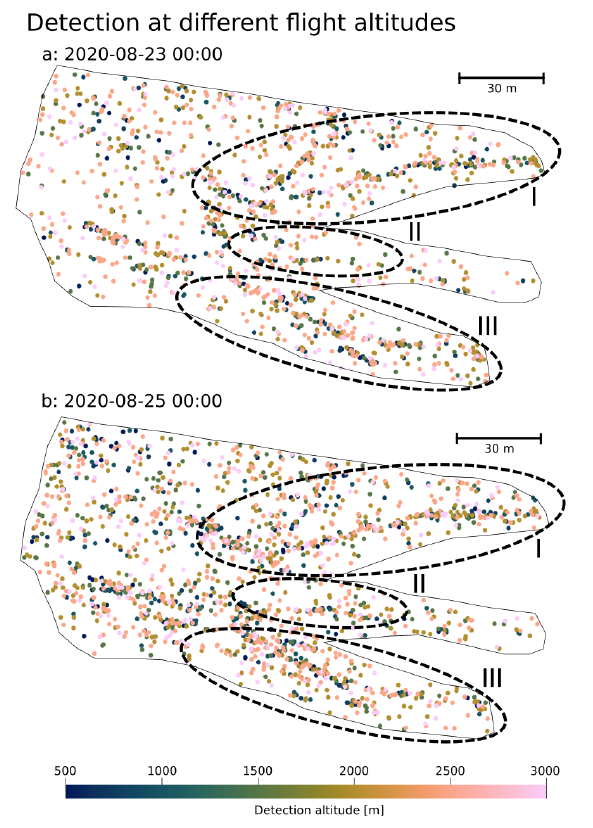
Figure 10. Points detected as significant for two epochs (a and b), coloured by the maximum altitude where they were detected. For example, green points were detected as significant change for altitudes of 1500 m and below, but not for higher altitudes. Note that this plot is turned counterclockwise by 90 degrees with respect to the other plots in this paper to allow for a larger display